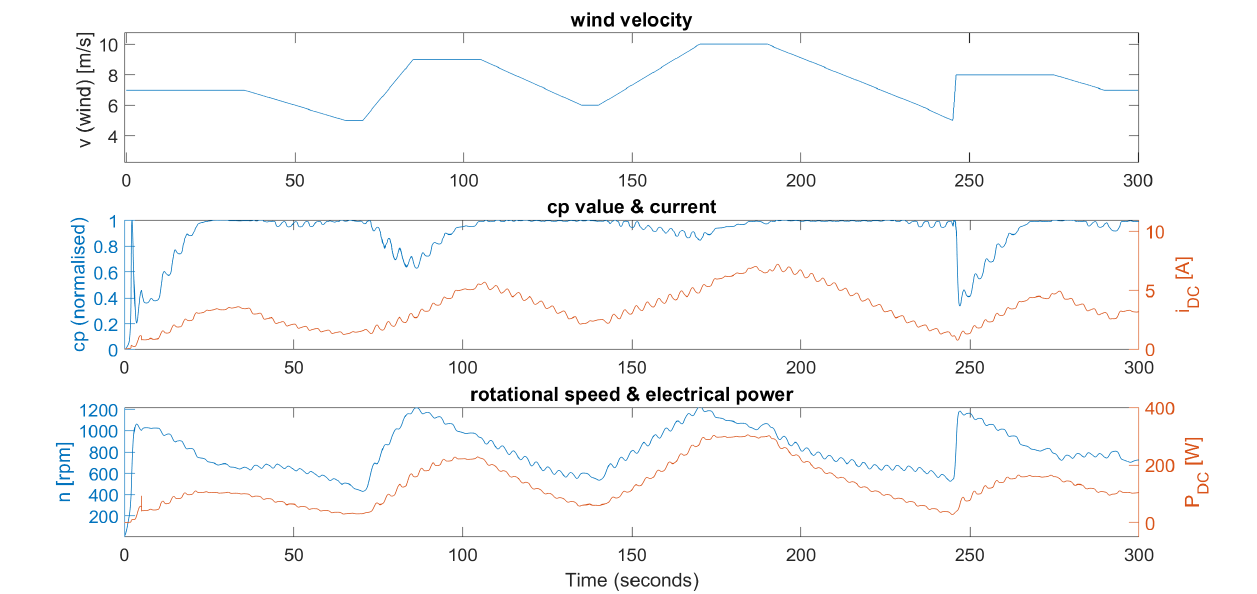
Figure 4. Simulation results with a nominal wind regimen composed of slow and fast changing wind velocities. A c P value of one indicates a reached maximum power point, i.e., the controller operates optimally for the given wind velocity. A normalized c P value is shown in